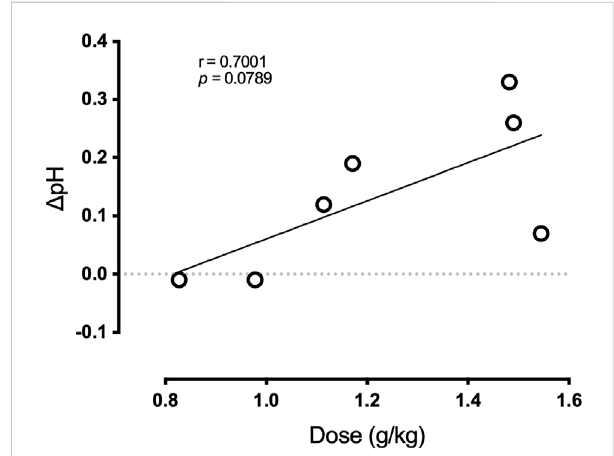
Relation of dosage to the change in intramuscular dialysate pH during the primary